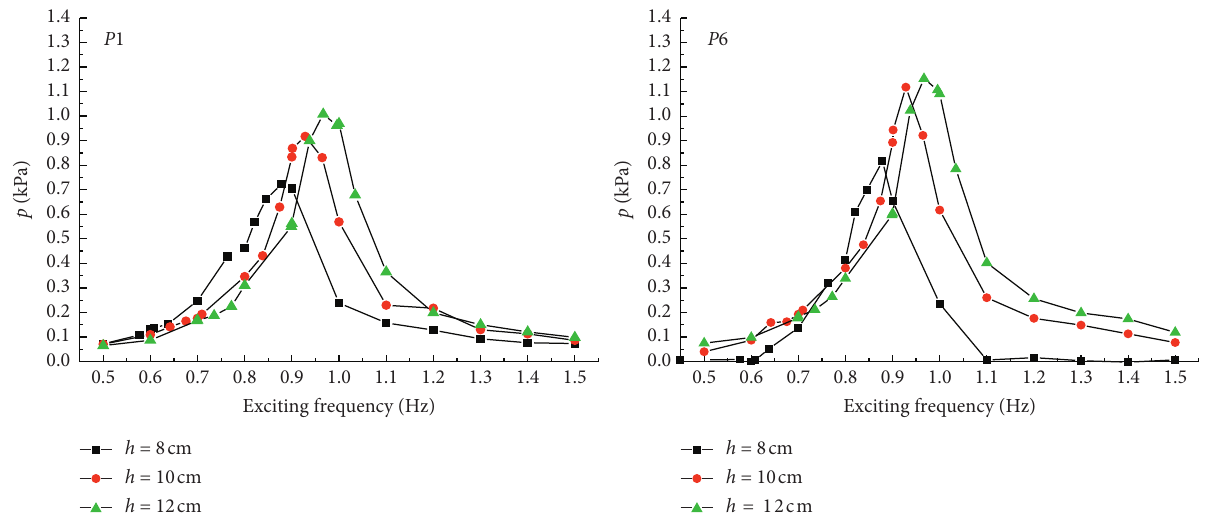
Figure 6: Maximum pressure amplitude at different total liquid depths with various exciting